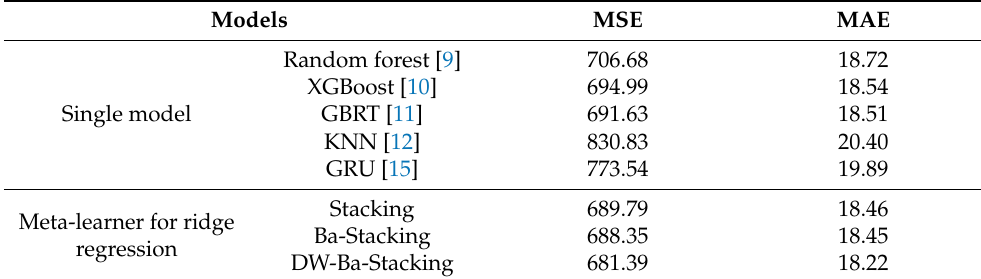
Table 7. The comparison table of different models. Models MSE